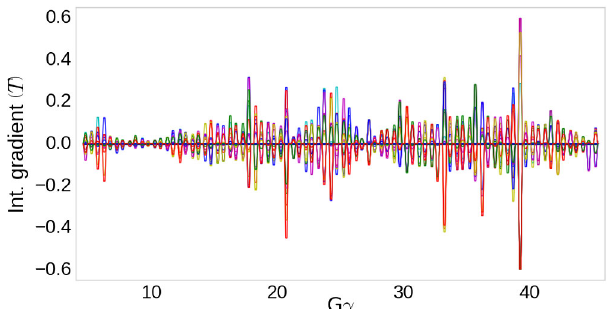
FIG. 2. Integrated skew quadrupole gradients as a function of G γ calculated for the correction of partial snake drive horizontal resonances in the AGS. Each trace represents one of the 15